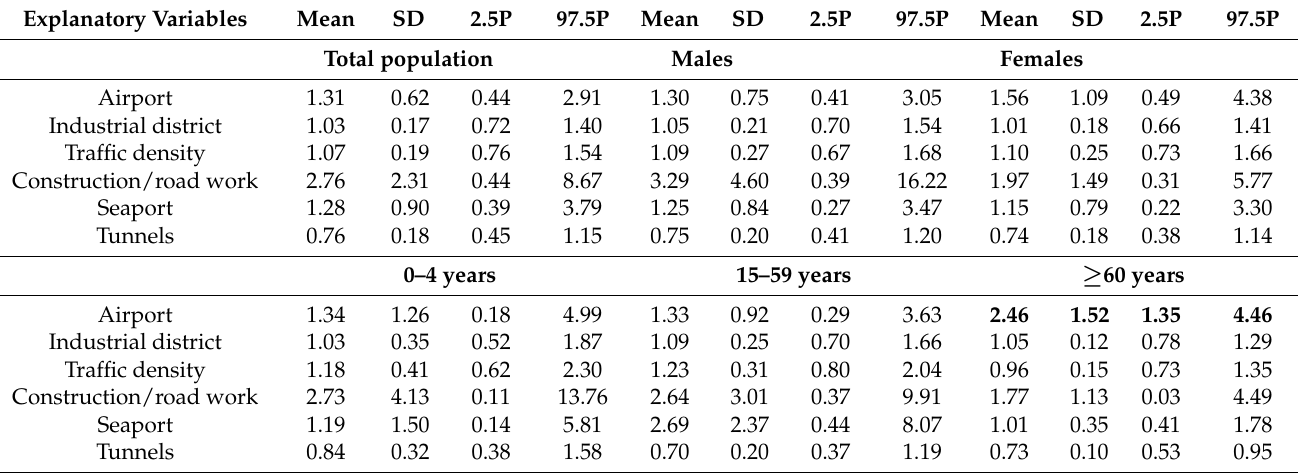
Table 2. Association between potential air pollution sources (explanatory variables) and ratio of hospitalization for respiratory disease in the city of Rio de Janeiro PAs